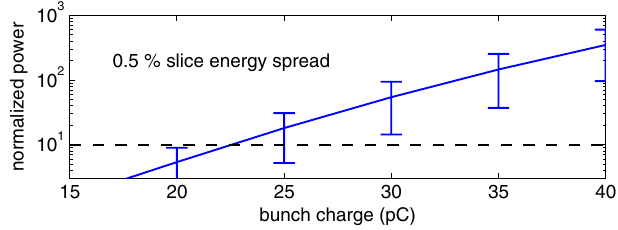
FIG. 3. Normalized power (log scale), for a chirped bunch, (cid:7) ¼ 1% =(cid:1) , with a slice-energy spread of ^ (cid:1) z ¼ 0 : 5 (cid:10) m are sufficient to demonstrate FEL 20 pC in (cid:1) z